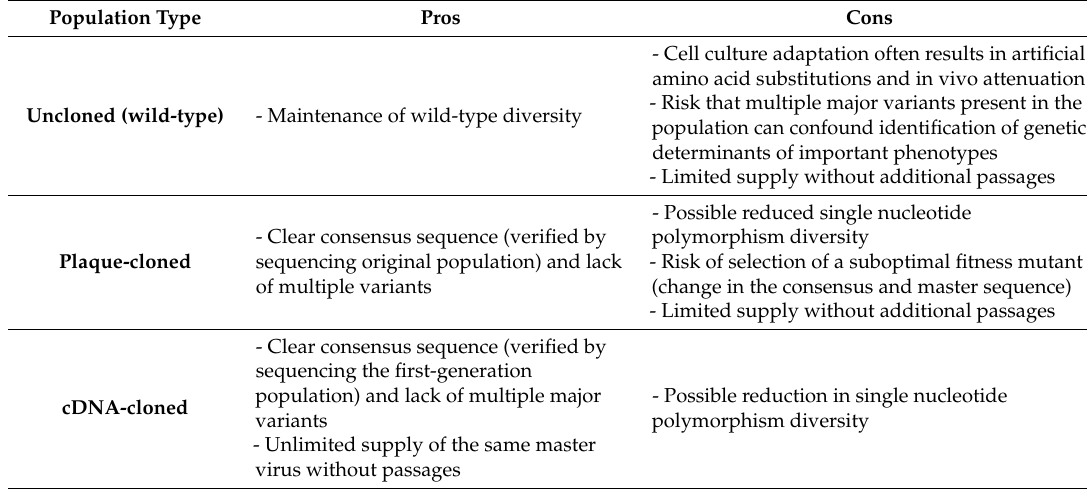
Table 3. Comparison of pros and cons for three methods of the propagation of VEEV